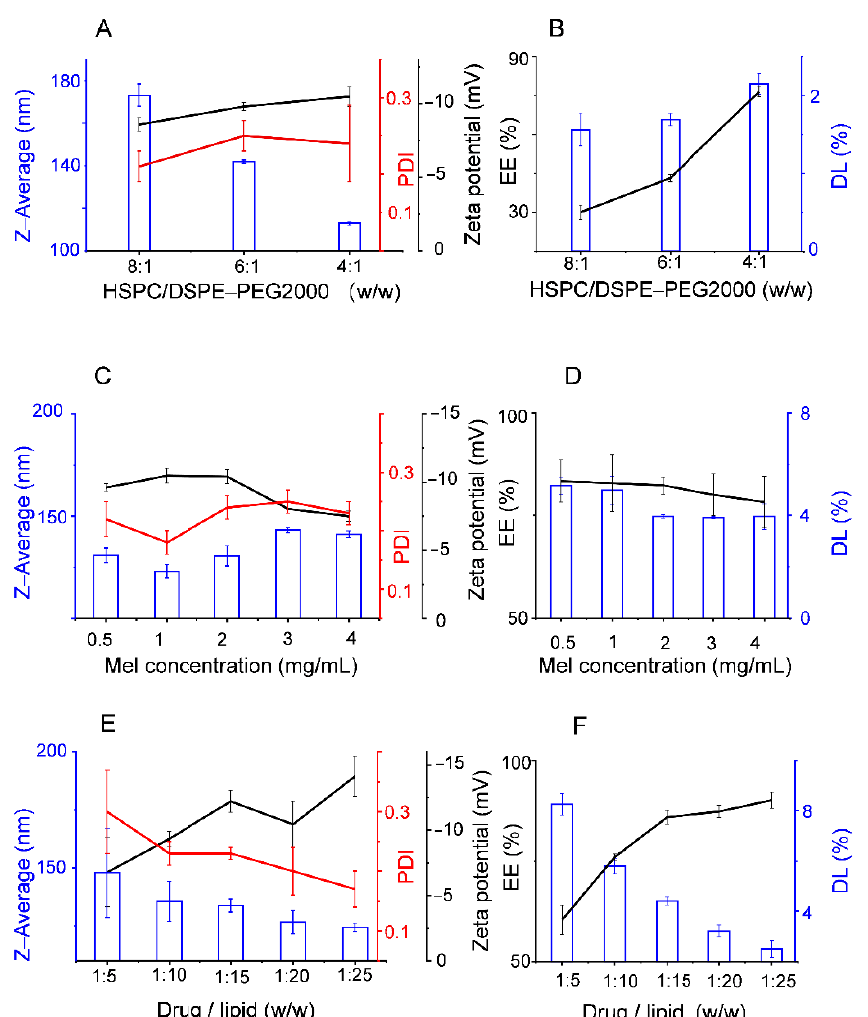
Figure 3. Effect of different factors during the preparation process on the characteristics of Mel-Lip: HSPC to DSPE-PEG2000 mash ratio ( A , B ), concentration of melittin ( C , D ), drug to lipid mass ratio ( E , F ). ( n = 3). Table 1. Uniform design for the selection of a Mel-Lip formulation. ( n = 3).